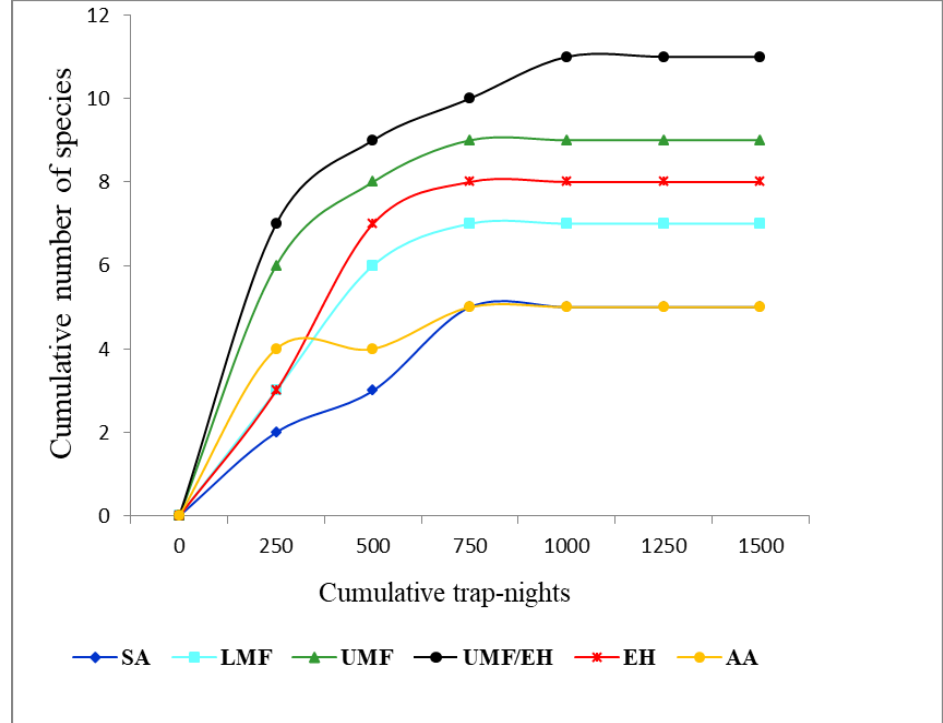
Figure 5. Species accumulation curves for elevations surveyed. The AS and AA sites had the same number of cumulative species starting from the third day of trapping. Asymptote reached on all sites. Trapping effort experssed as trap-nights. SA (savanna); LMF (lower montane forest); UMF (upper montane forest); UMF/EH (upper montane forest/Ericaceous heathland); EH (ericaceous heathland); and AA (Afroalpine).